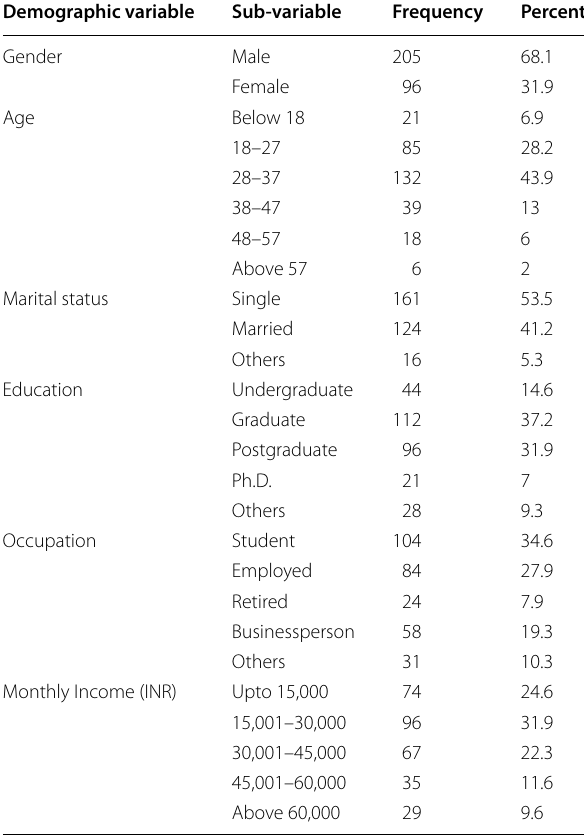
301). Source : Primary Data =